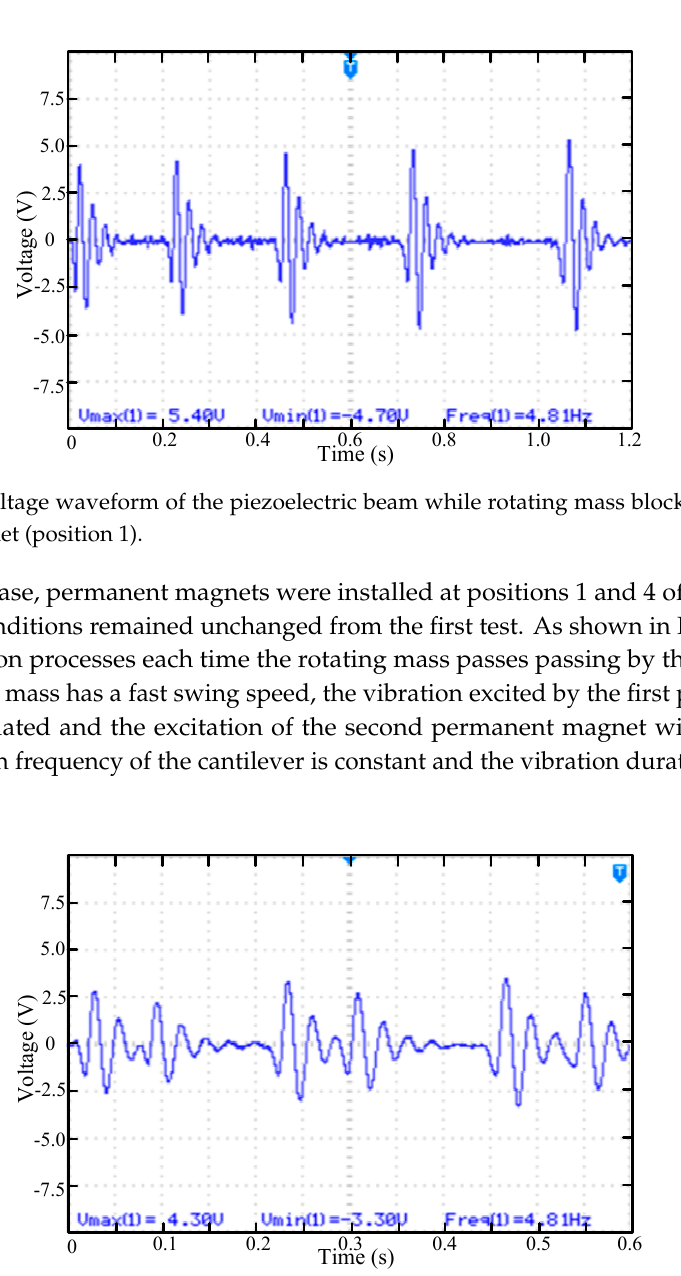
Figure 7. The voltage waveform of the piezoelectric beam while rotating mass block rotates with two permanent magnets (positions 1,4).